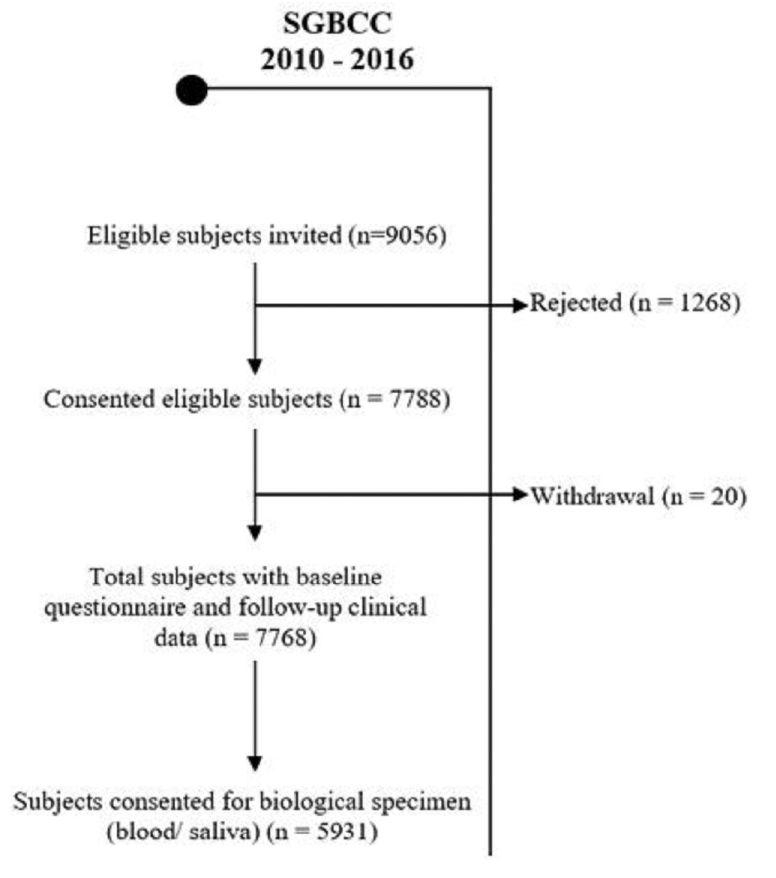
Fig 2. Flow chart of study participants as of 31 December